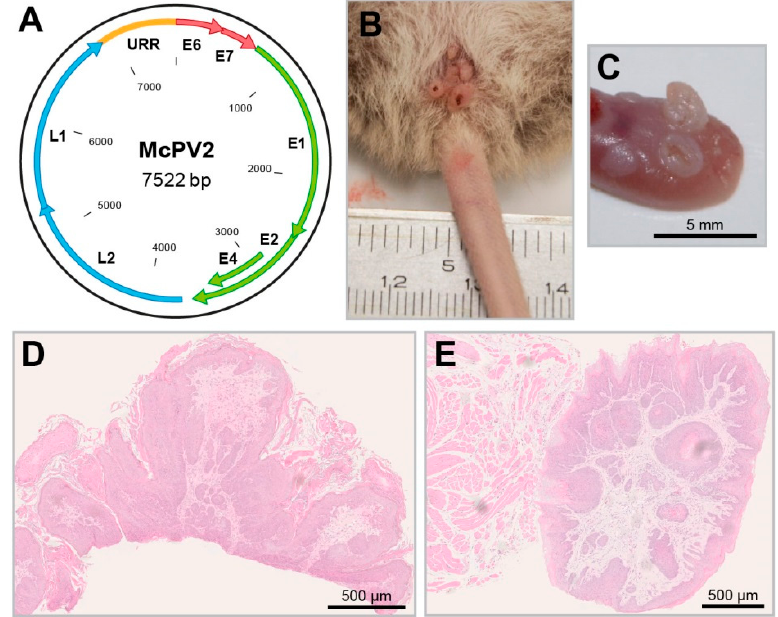
Figure 5. The Mastomys coucha papillomavirus 2. ( A ) Schematic representation of the McPV2 genome. ( B ) Condylomas in the anogenital region induced by McPV2. ( C ) Tongue papillomas induced by McPV2 (these are frequently positive for MnPV as well). ( D ) HE staining of a condyloma. ( E ) HE staining of a tongue